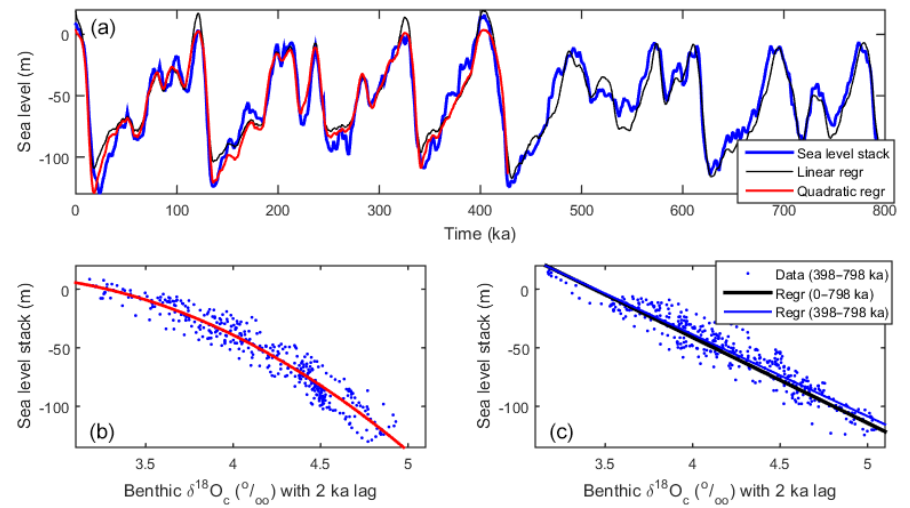
Figure 4. Comparison of benthic δ 18 O c and sea level. (a) Linear and quadratic sea level models (Eqs. 1, 2, respectively) using smoothed benthic δ 18 O c (Lisiecki and Raymo, 2005) lagged by 2ka. (b) Data from 0 to 397ka with quadratic regression (red line). (c) Data from 398 to 798ka with linear regression for 0–798ka (black line) and 398–798ka (blue line).